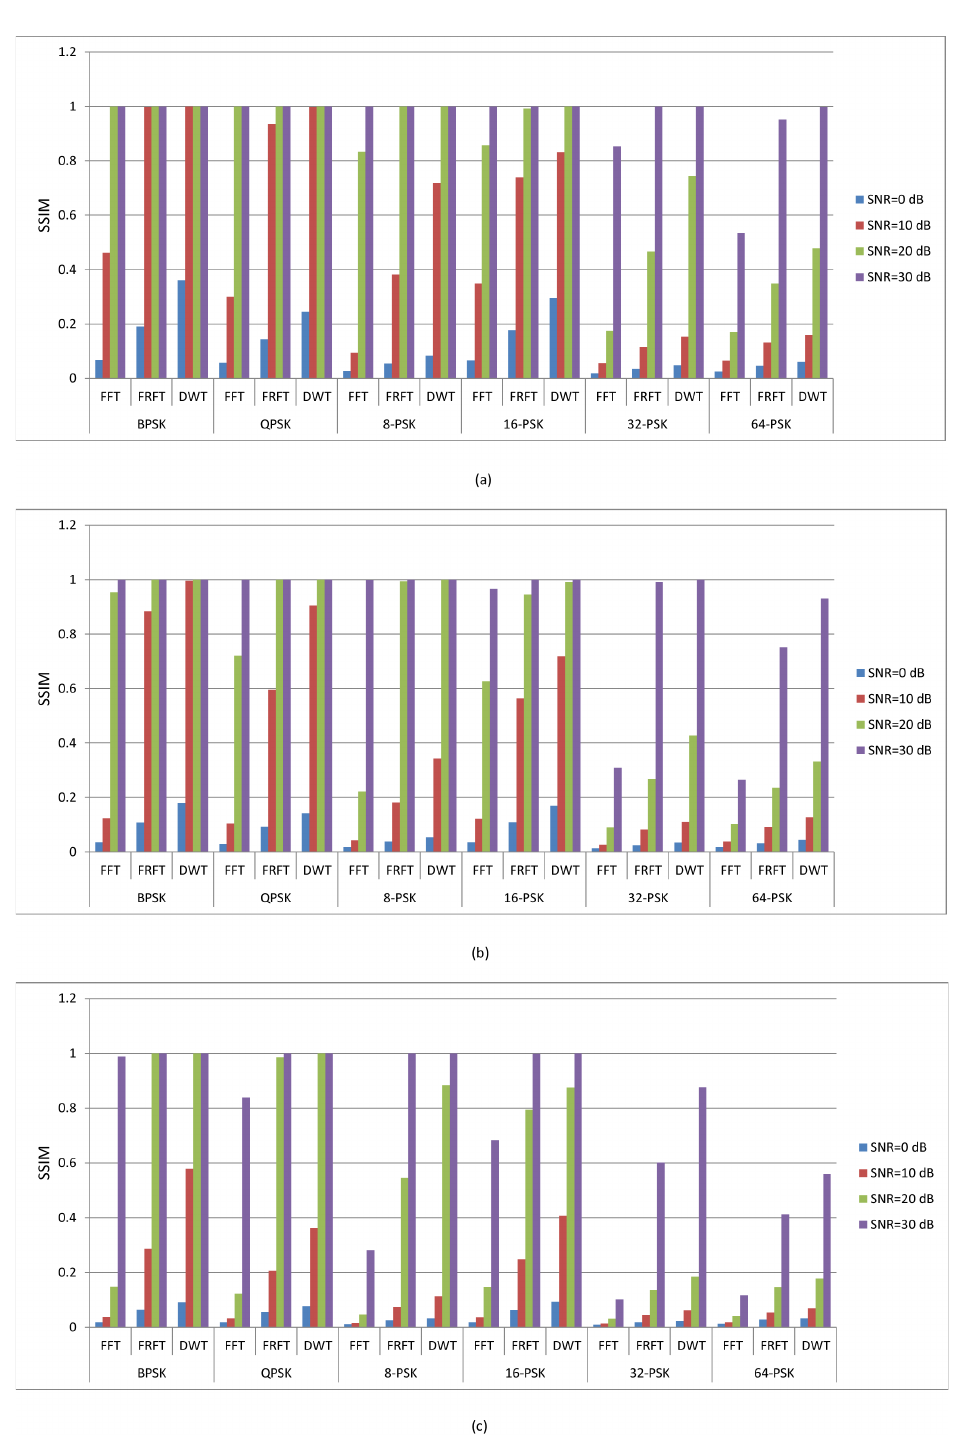
Figure 23. SSIM variations for Massive MIMO incorporated FFT-OFDM, FRFT-OFDM and DWT- OFDM for various modulation levels and number of users over Rayleigh Channel. ( a ) n = 10; ( b ) n = 20; ( c ) n =